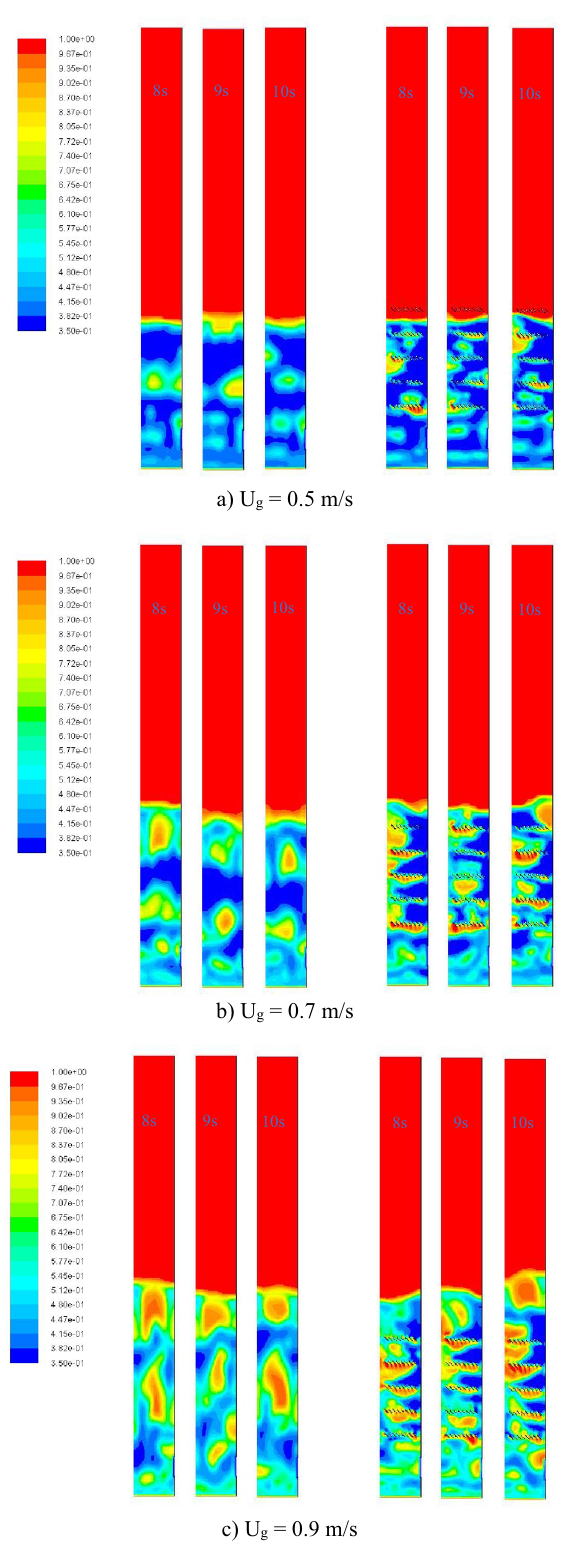
Figure 6. Voidage (gas fraction) contours inside the no-baffle gasifier (left) and the baffled gasifier (right) snapped at 8, 9, 10 s when operating at various gas inlet